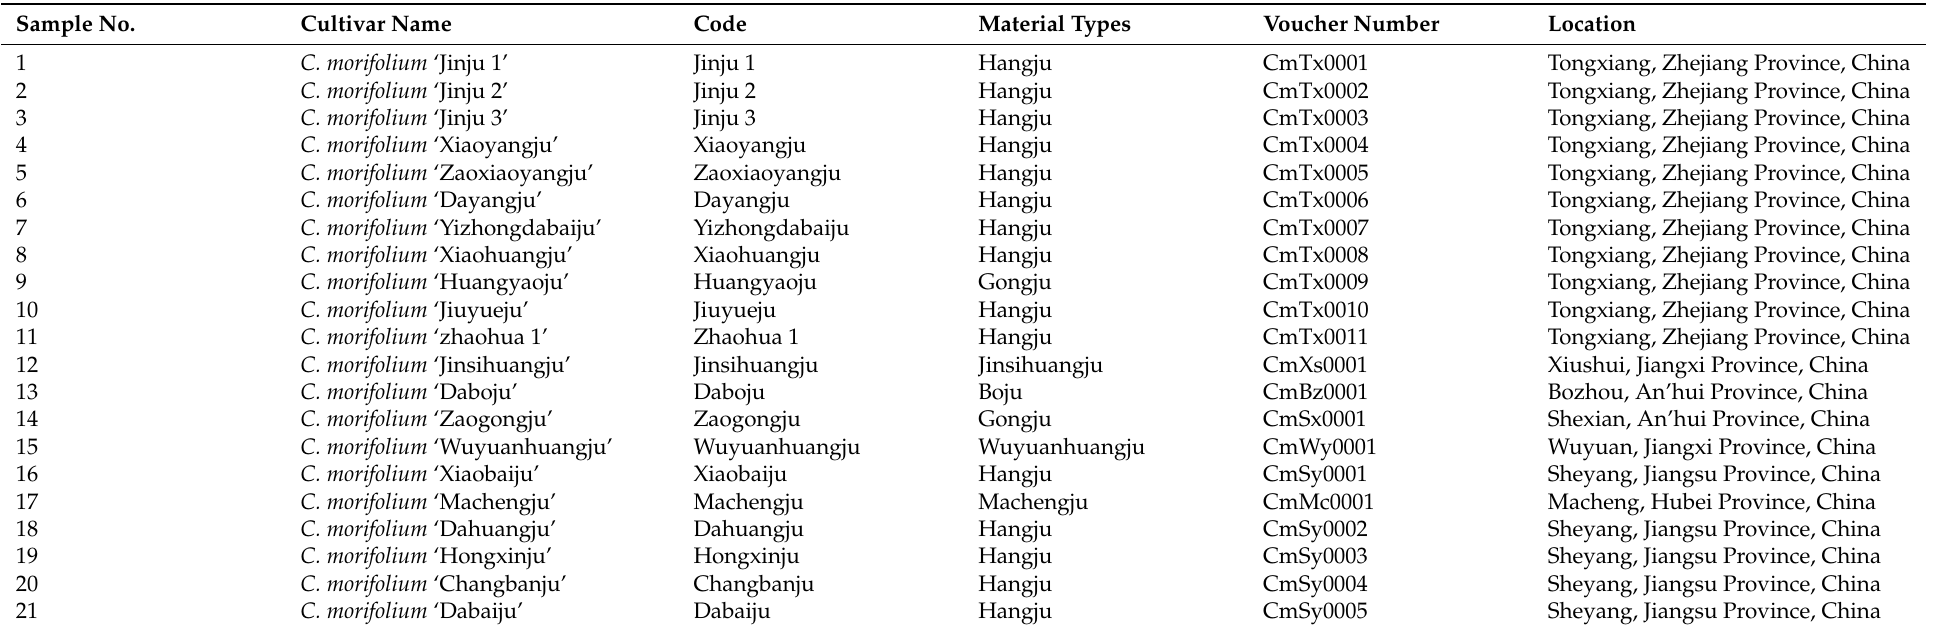
Table 4. Details of Chrysanthemum morifolium samples used in the study. Sample